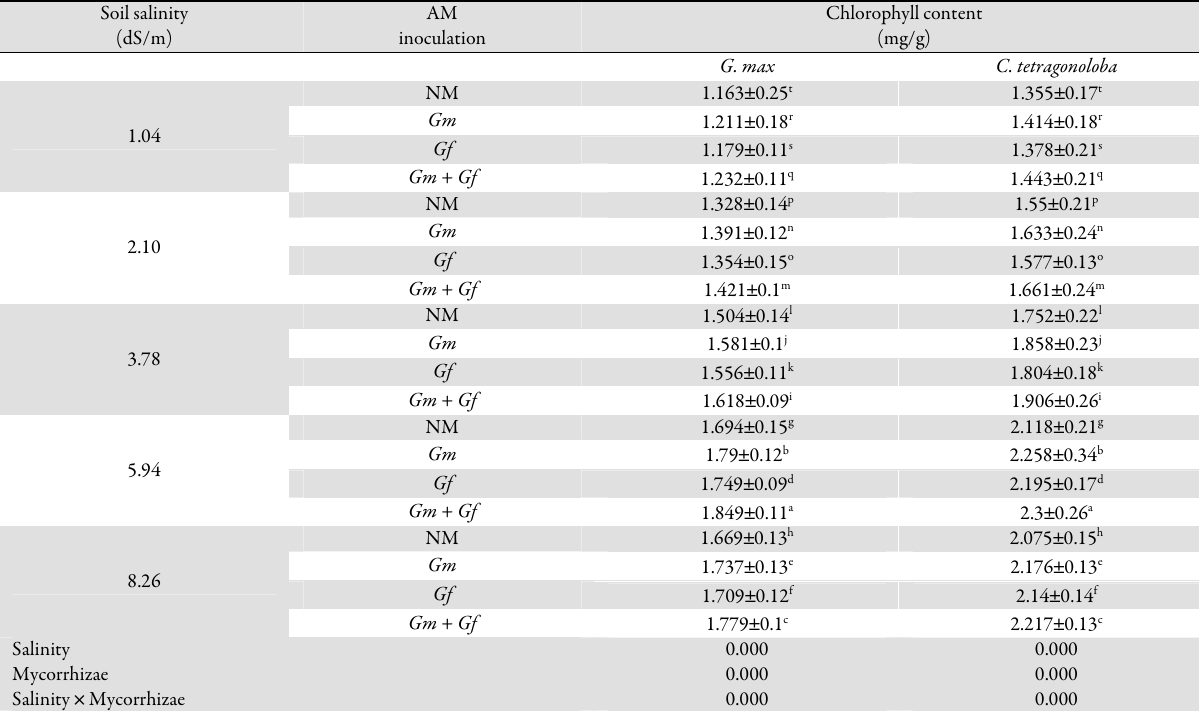
Tab. 6. Total proline content (μmol/g) of mycorrhizal and non-mycorrhizal G. max and C. tetragonoloba grown under control (1.04 dS/m) and at increasing soil salinity levels (2.10 to 8.26